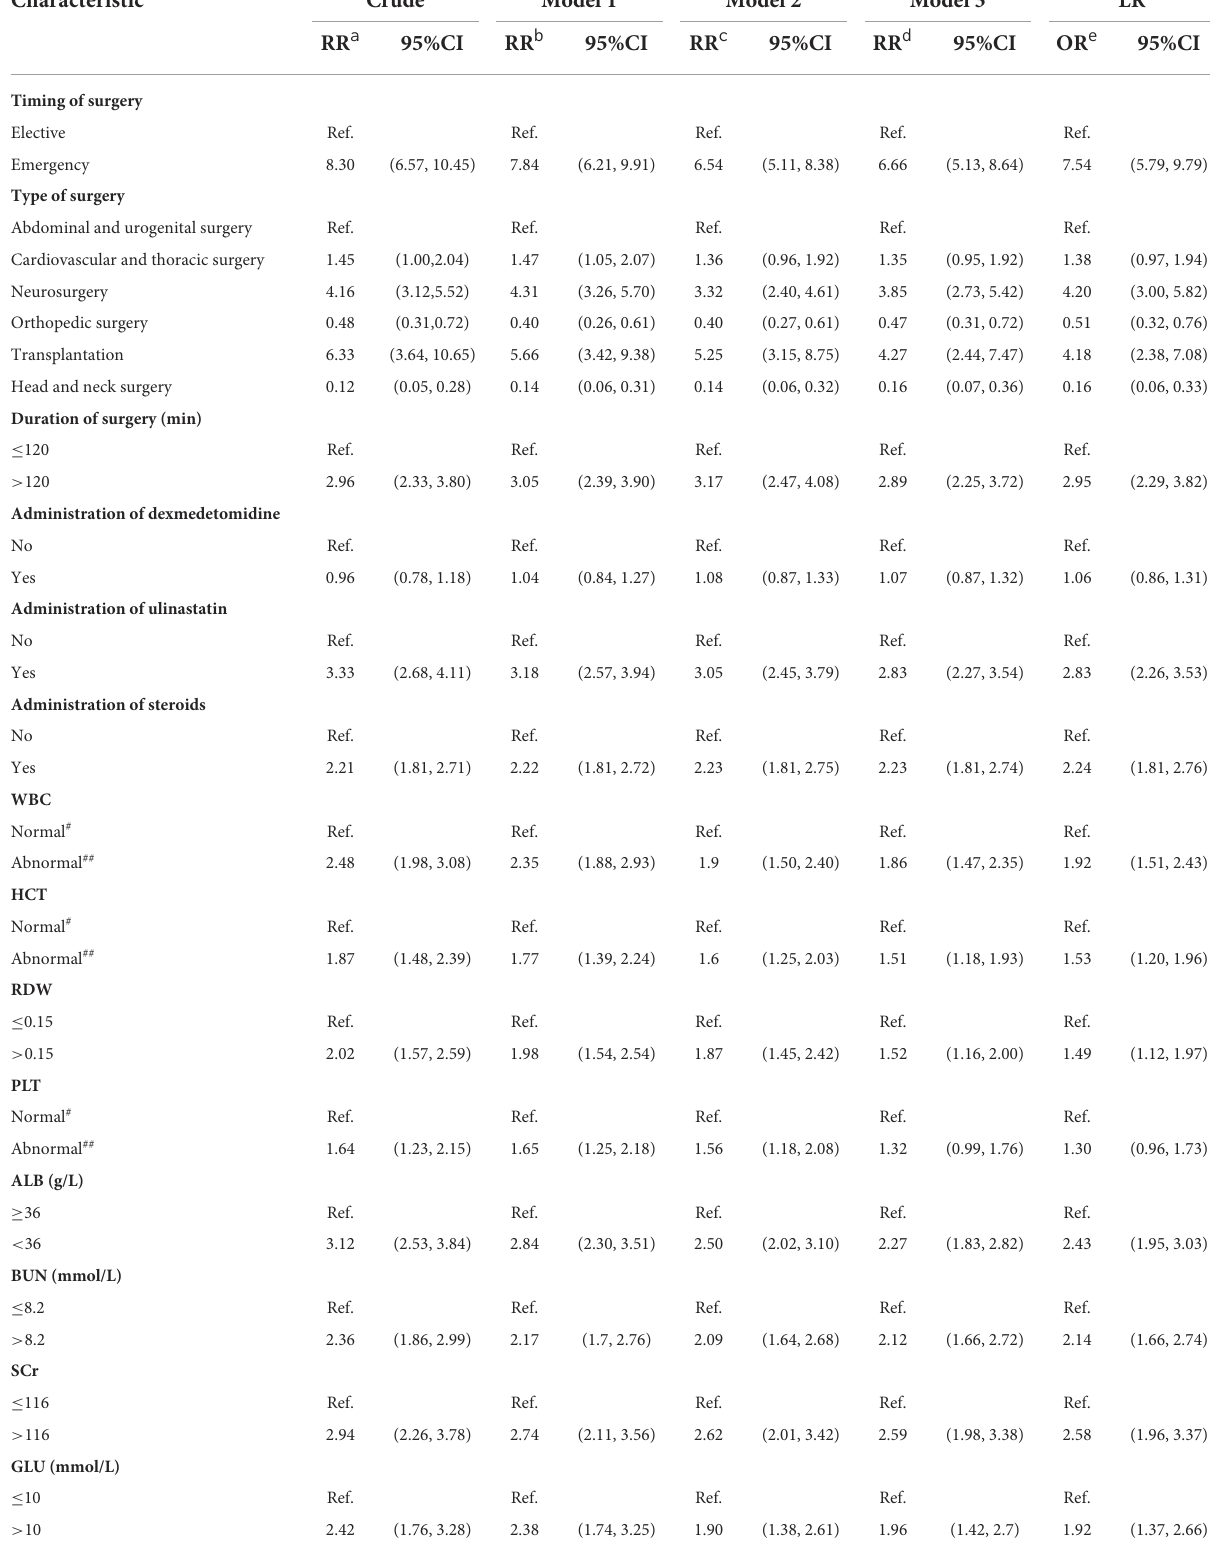
TABLE 2 Putative risk factors for